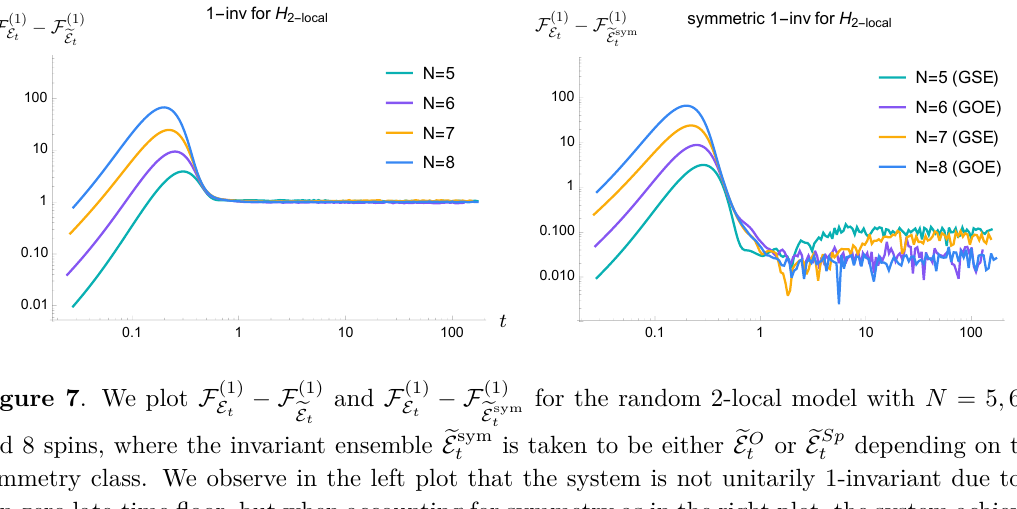
Figure 7 . We plot F (1) − F (1) and F (1) − F (1) for the random 2-local model with N = 5 , 6 , 7 E t E t e E t e E sym t and 8 spins, where the invariant ensemble e E sym is taken to be either e E O or e E Sp depending on the t t t symmetry class. We observe in the left plot that the system is not unitarily 1-invariant due to a non-zero late-time floor, but when accounting for symmetry as in the right plot, the system achieves approximate 1-invariance at late